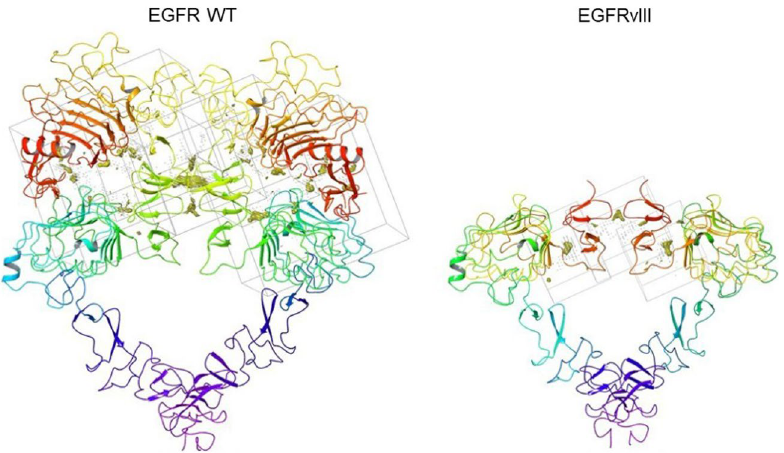
Figure 5. Structures and active site regions of EGFR WT and EGFRvIII proteins. The figure shows EGFR WT with 1388.2 cubic Å hydrophobic region (left) and EGFRvIII with 183.4 cubic Å hydrophobic region (right). The cubes show the secondary structures of both proteins.